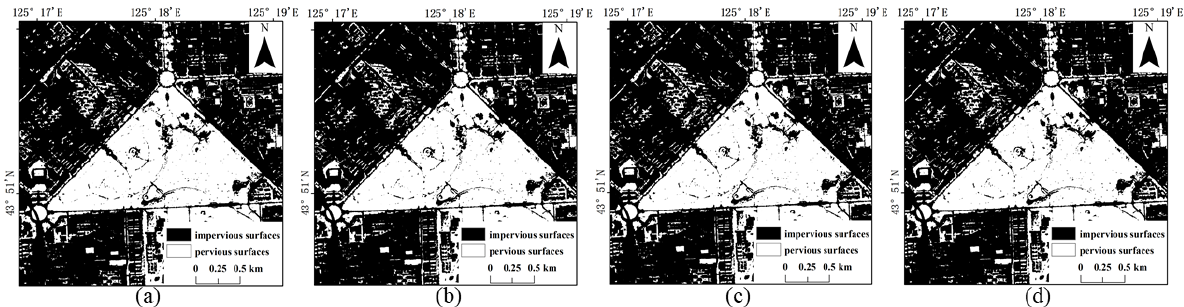
Figure 5. Results of impervious surface extraction with SVM: ( a ) 40,000 samples; ( b ) 60,000 samples; ( c ) 80,000 samples; ( d ) 100,000 samples.